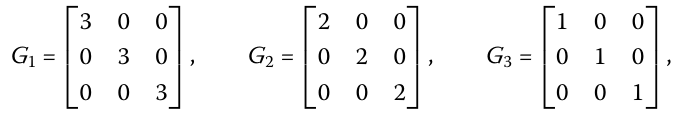
The parameters are selected as follows: the time-varying scaling function matrix α ( t ) = diag (. sin (  π ),. sin (  π ),. sin (  π )), the coupling strength c  = ., c  = ., c  =   